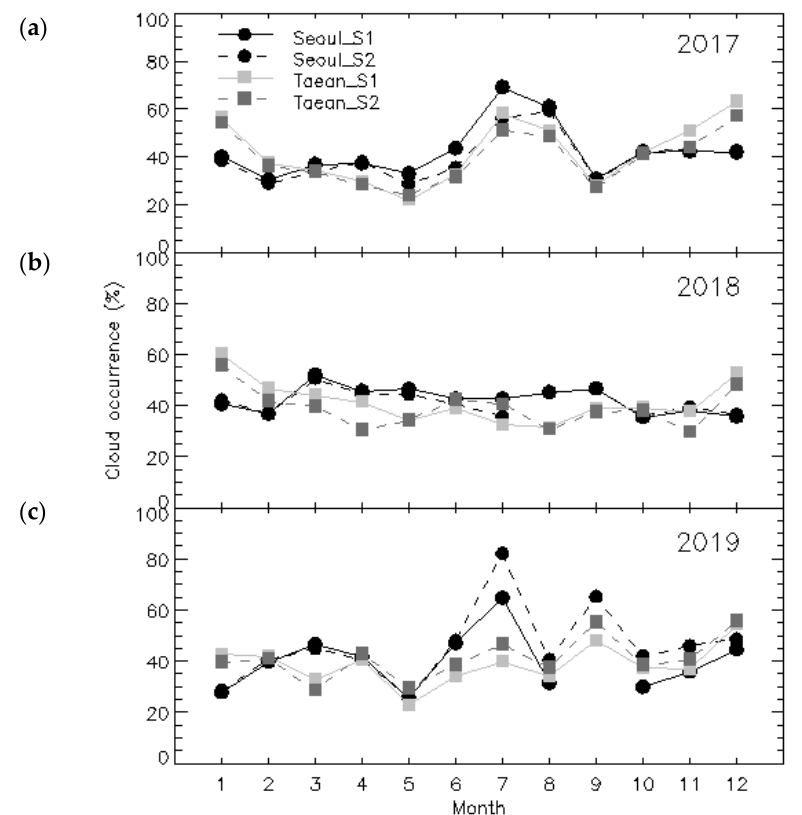
Figure 2. Annual variations of monthly cloud occurrence (0–7750 m) derived from ceilometer measurements at Seoul (Seoul_S1, Seoul_S2) and Taean (Taean_S1, Taean_S2) stations: ( a ) 2017, ( b ) 2018, and ( c ) 2019.